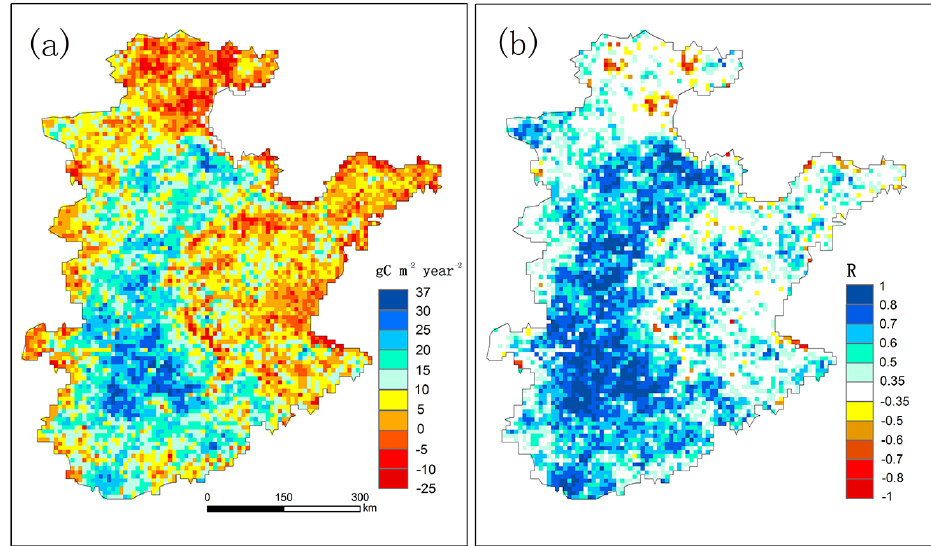
Figure 7. (a) Spatial distribution of GPP trends and (b) Pearson coefficients of trends at the p <0.05 significance